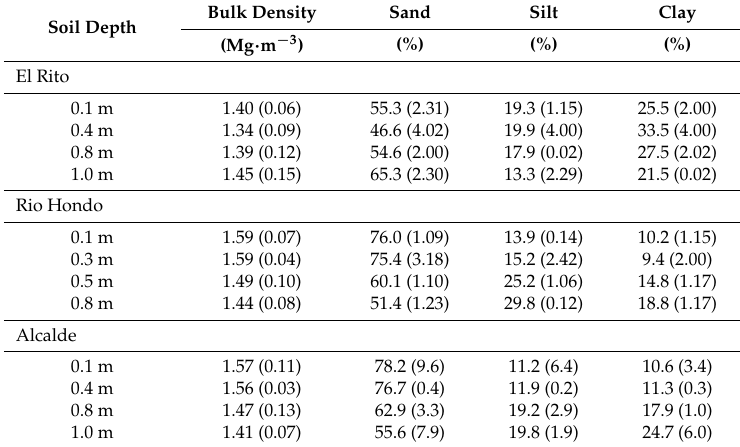
Table 1. Soil physical properties for the three study sites, El Rito, Rio Hondo, and Alcalde, showing the average of three samples for soil bulk density and soil particle distribution of sand, silt, and clay at each soil depth. Standard deviation is shown in